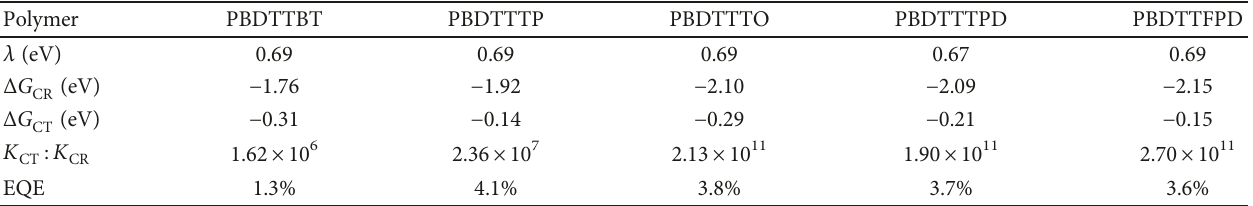
Table 3: Reorganization ( λ ), exciton dissociation energy ( Δ G and charge recombination rate ( K